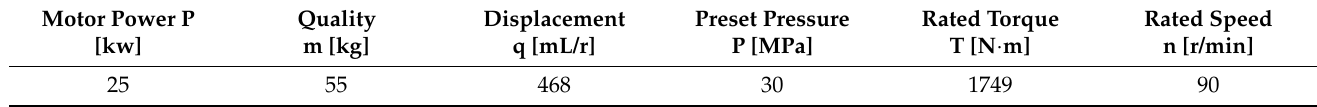
Table 2. Motor parameters.